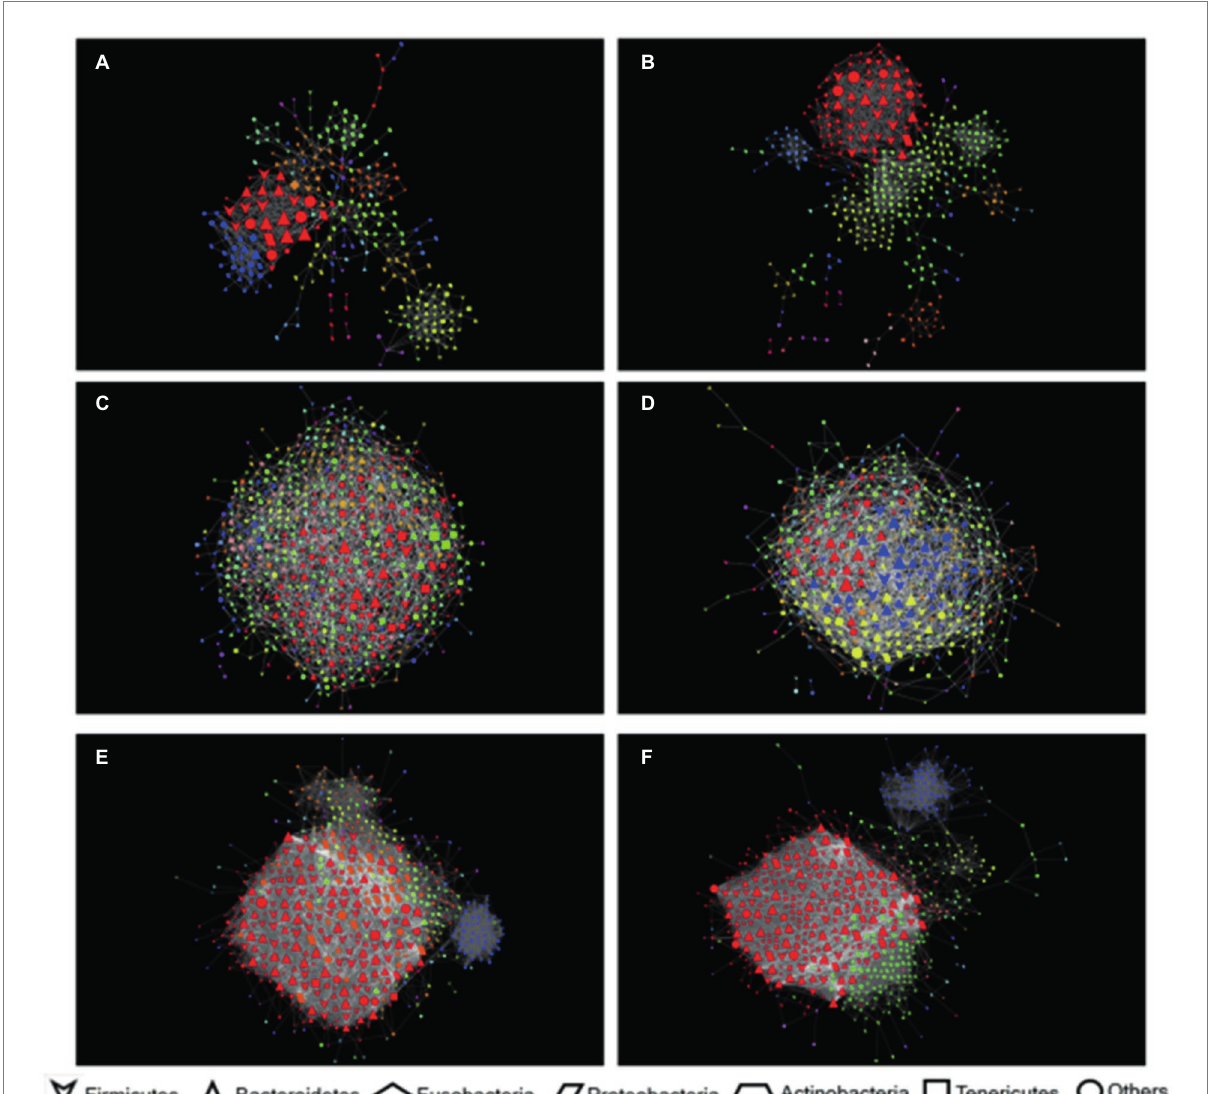
FIGURE 7 Network co-occurrence interactions of microbial communities of dental biofilm and ruminal fluid bovine samples. The nodes in this network represent OTUs and the edges that connect these nodes represent correlations between OTUs, filters with |r| = > 0.5 and p < 0.001. (A) Dental microbiomes of animals with periodontitis; (B) Dental microbiomes of healthy animals. (C) Ruminal microbiomes of animals with periodontitis; (D) Ruminal microbiomes of healthy animals; (E) Dental and ruminal microbiomes of animals with periodontitis; (F) Dental and ruminal microbiomes of healthy